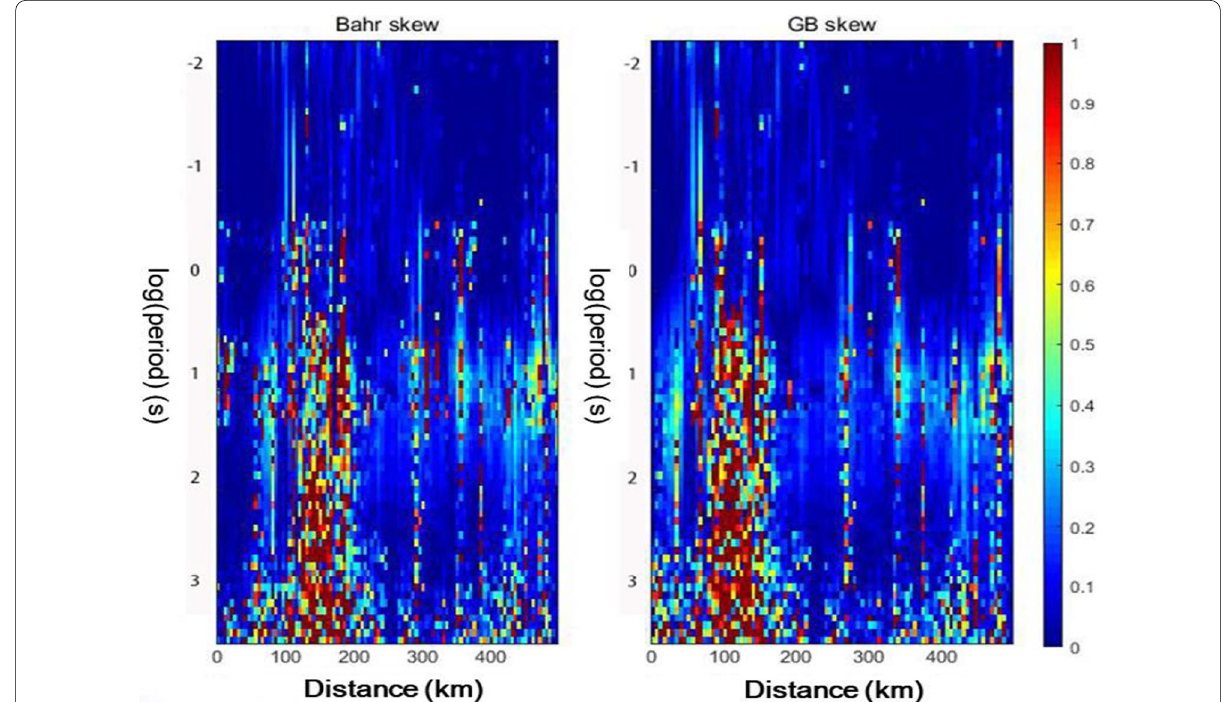
Fig. 3 Bahr and GB Skewness. The left side represents the north